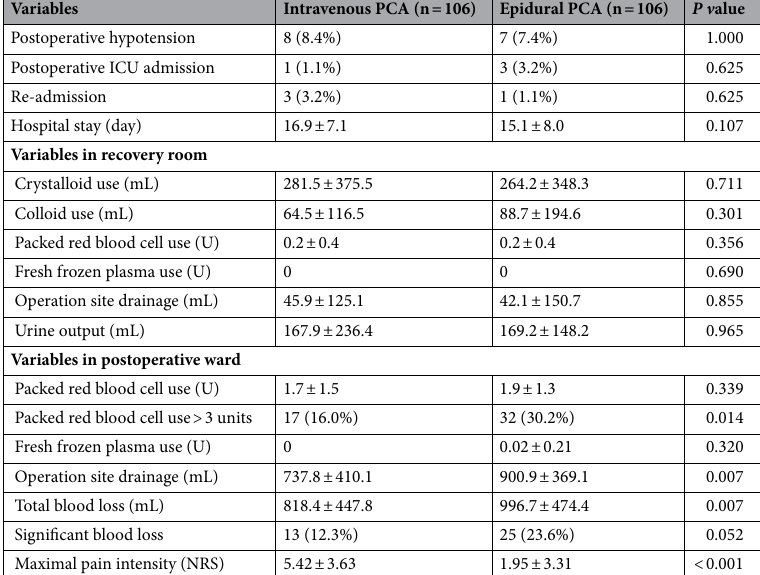
Table 6. Postoperative variables between the intravenous PCA and epidural PCA groups: PS-matched data. Data are presented as mean ± standard deviation or number (%), as appropriate. PCA patient- controlled analgesia, PS propensity score, ICU intensive care unit. Postoperative hypotension = systolic blood pressure < 90 mmHg, diastolic blood pressure < 60 mmHg within postoperative day 3, NRS = numerical rating scale.